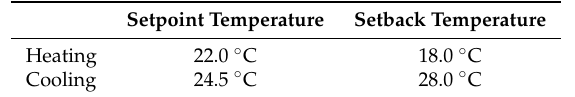
Table 8. Zone air temperature setpoints and setback temperatures used in building